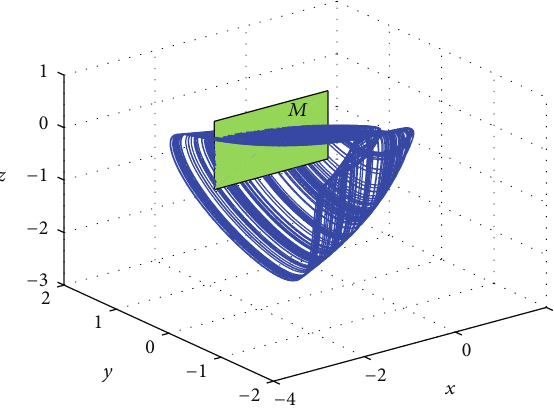
Figure 1: A chaotic attractor of (12) and cross-section 𝑀